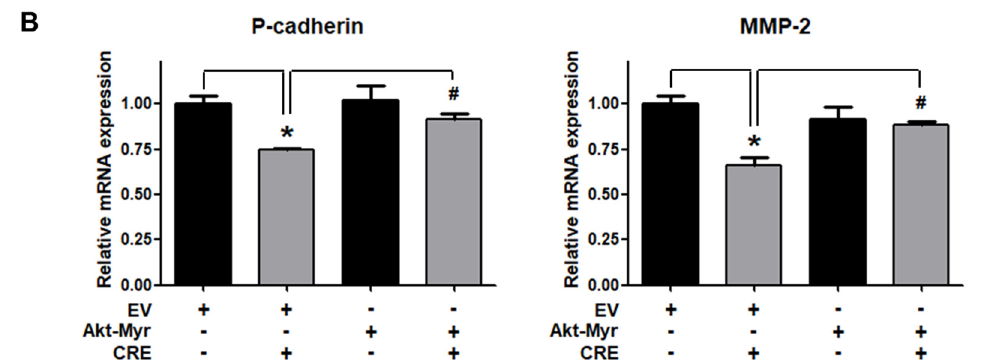
Figure 4. Involvement of the Akt pathway in endometriotic cell adhesion to mesothelial cells and expression of adhesion molecules in endometriotic cells. 12Z cells were transfected with an empty vector (EV) or a constitutive active form (Akt-Myr), and then the cells were treated with CRE (100 µ g/mL). After 24 h, ( A ) an adhesion assay and ( B ) a real-time RT-PCR were performed. The mRNA expression of P-cadherin and MMP-2 was normalized to GAPDH. * p < 0.05 compared with EV- transfected none treatment group and # p < 0.05 compared with EV-transfected CRE treatment group.